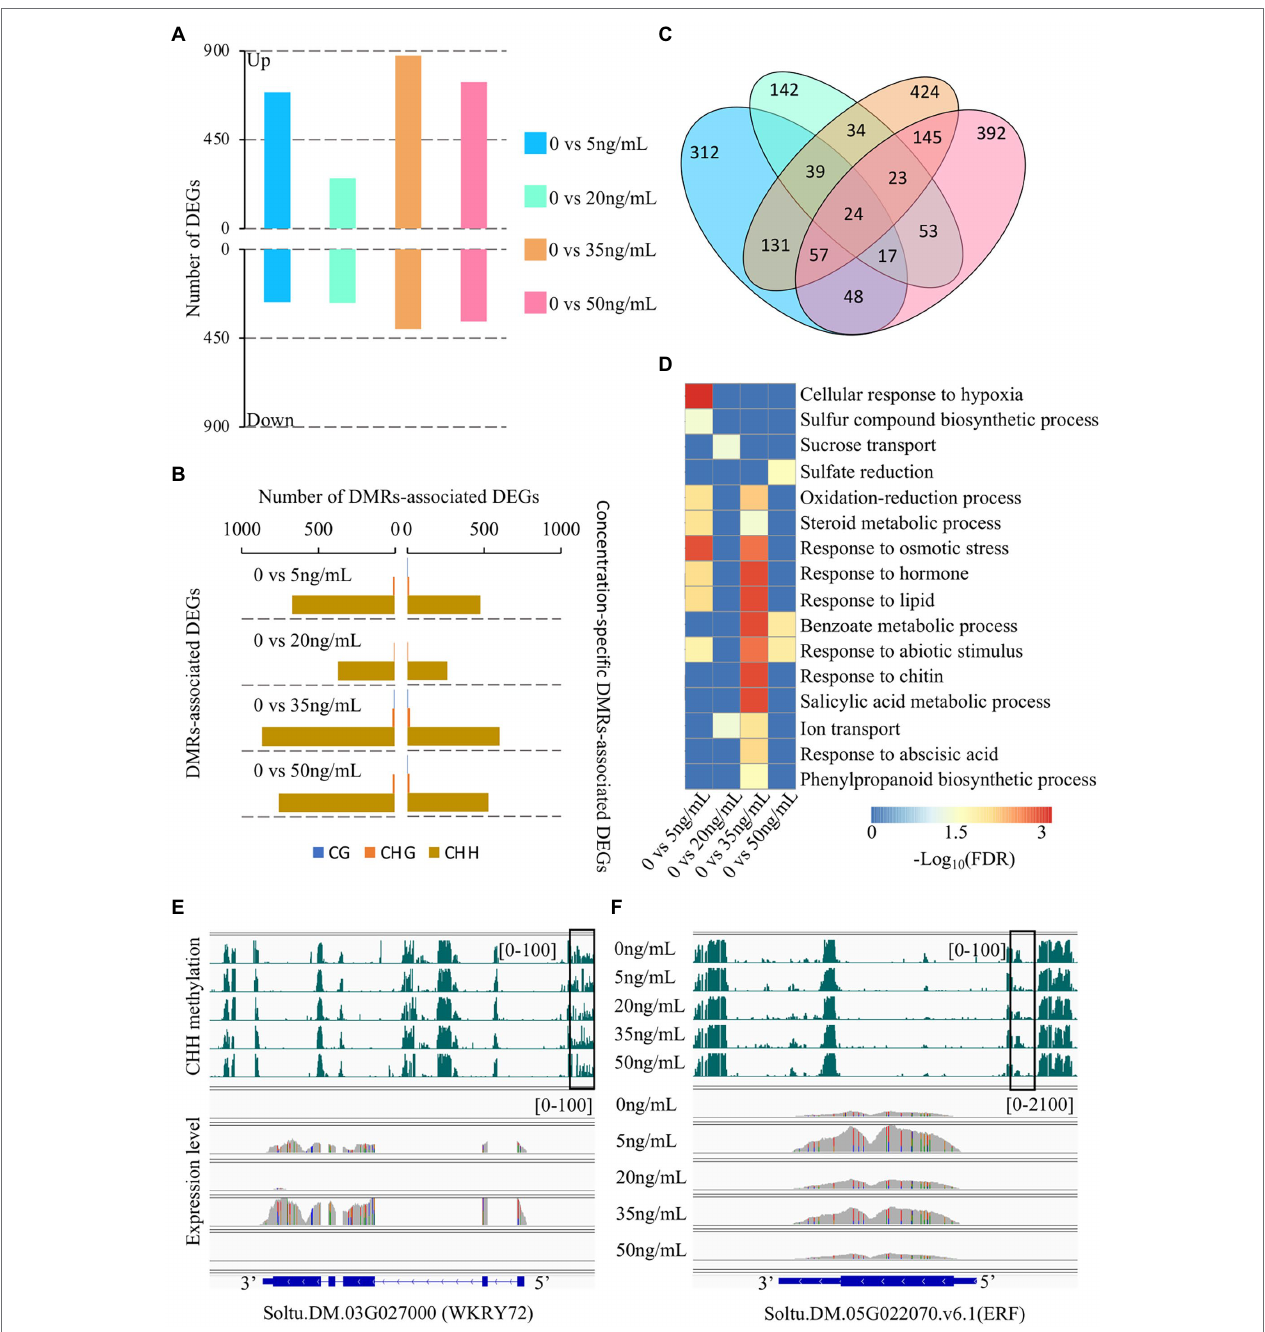
FIGURE 4 | Characterization of differential methylation regions (DMRs)-associated differentially expressed genes (DEGs). (A) The number of DEGs after different DON concentration treatments, 0 vs. 5, 20, 35, and 50 ng/ml. (B) The number of DMR and concentration-specific DMRs-associated DEGs. (C) The Venn diagram shows the number of specific DMRs-associated DEGs. (D) Enriched gene ontology (GO) terms for DMR associated DEGs after different DON concentration treatments. (E,F) Snapshots of CHH DMR-associated DEGs at different concentrations of